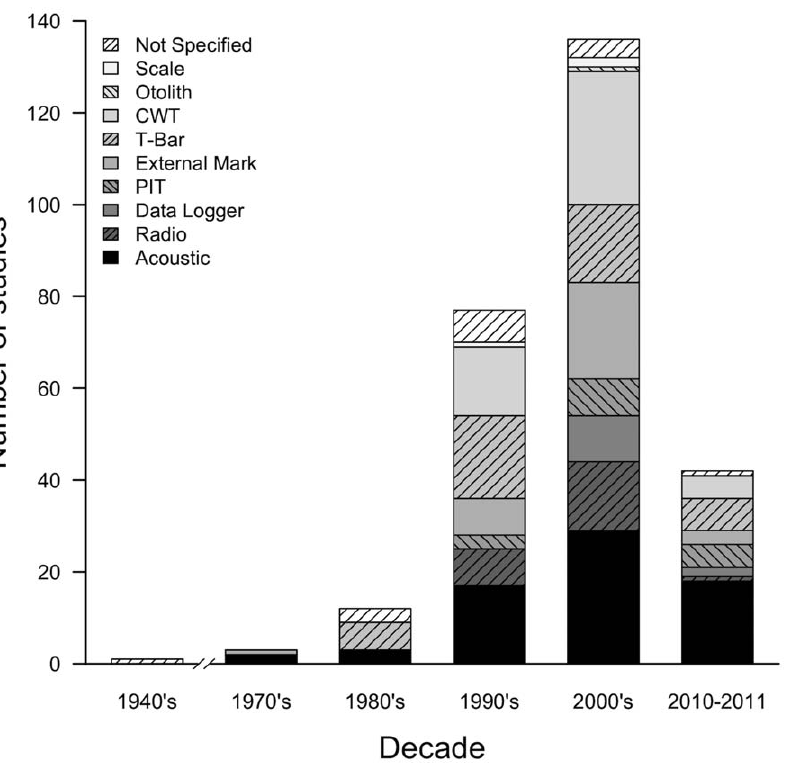
Figure 2. Number of use of specific tag types by publication decade. Total number of tag use (n=271) exceeds that of reviewed papers (n=207) because many studies used more than one tag type. The category ‘‘T-Bar’’ includes carlin, cinch, spaghetti, Floy, and Petersen disk tags. The plot does not include data from a paper published in 1940 because the tag type used was not specified by the author.